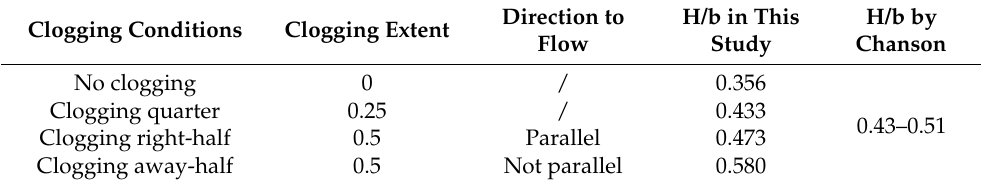
Table 5. Incoming critical state water depth under different clogging conditions.